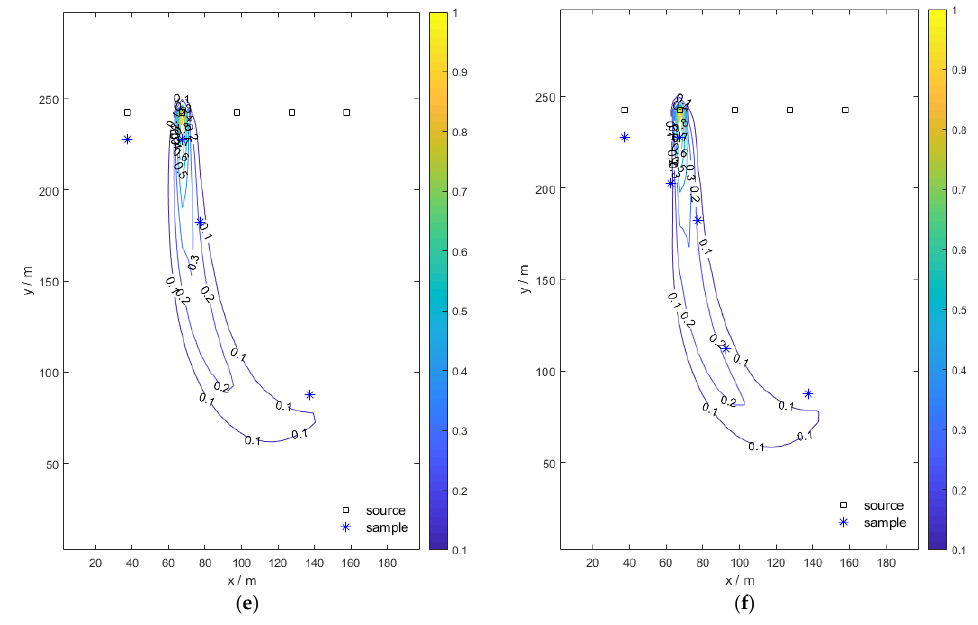
Figure 9. The normalized contour map of the pollution plumes: ( a ) True plume. ( b ) Superposed plume after the Kalman filter (1 point). ( c ) Superposed plume after the Kalman filter (2 points). ( d ) Superposed plume after the Kalman filter (3 points). ( e ) Superposed plume after the Kalman filter (4 points). ( f ) Superposed plume after the Kalman filter (6 points).